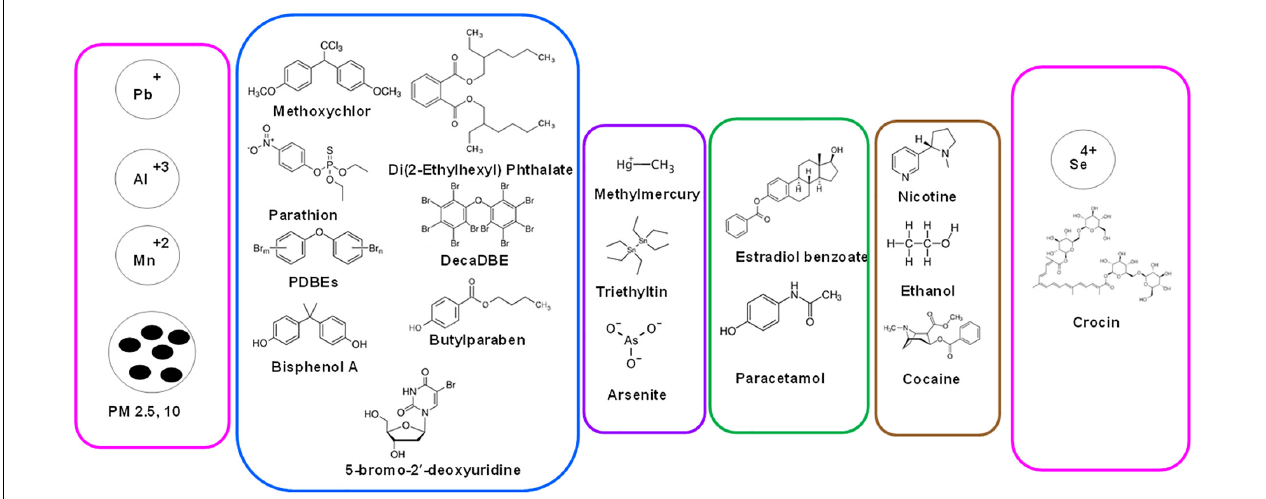
FIGURE 2 | Range of human chemical exposures that are associated with aging. From heavy metals/ ions to particulate matter (PM) of various sizes (PM 2 . 5 , PM 10 ), carbon black (BC), pesticides, PDBEs, phthalates, BPA, drugs (methamphetamine, paracetamol) to metalloids (methylmercury, arsenate) to chemicals from addiction (ethanol, nicotine, cocaine). Shown also are selenium and crocin (from Saffron plant) that exert protective effect on aging.